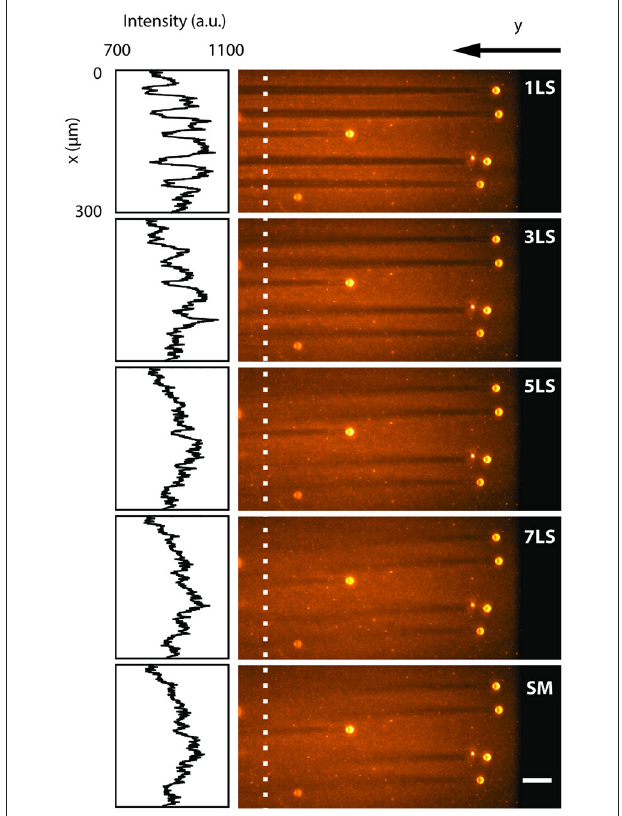
FIGURE 2 | LSFM images acquired by illuminating with different light-sheet configurations (1, 3, 5, 7 static sheets at different angles and single-plane sweeping mode) a single plane of a sample of 15 µ m polystyrene beads embedded in a 1% agarose gel and immersed in water. The insets show the fluorescence intensity profiles along the y-axis, averaged over 6 µ m around the white dotted line. The line plots depict how the background becomes more uniform with an increasing number of illumination directions. White scale bar of 50 µ